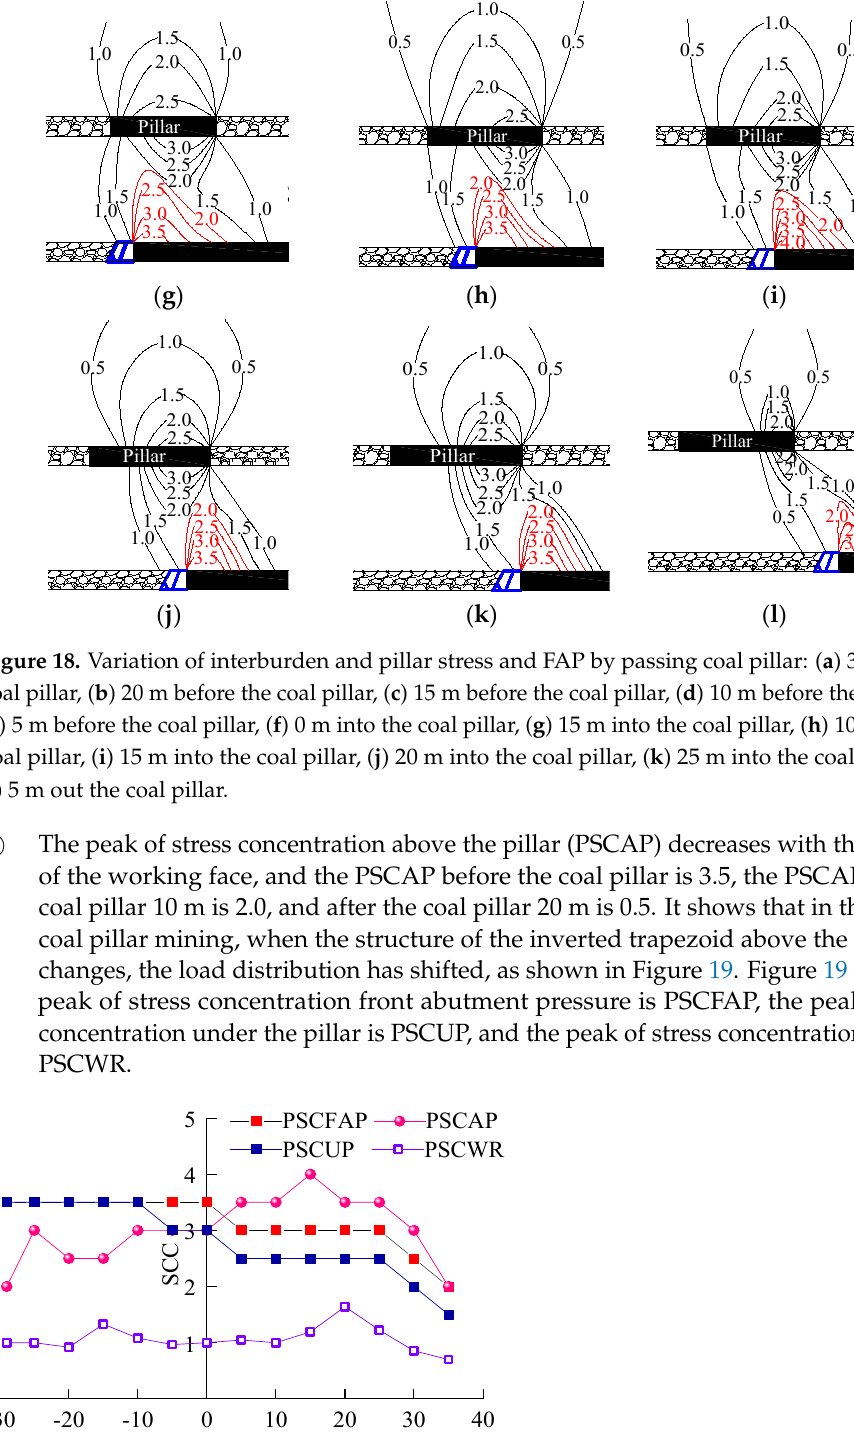
Figure 19. The mutual transformation between the WR, FAPC, and coal pillar during the passing of the pillar.